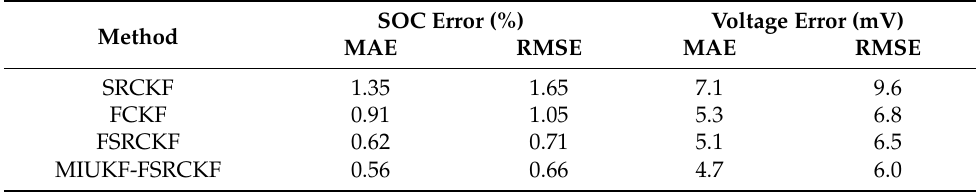
Table 3. SOC error and voltage error of each algorithm under the FUDS